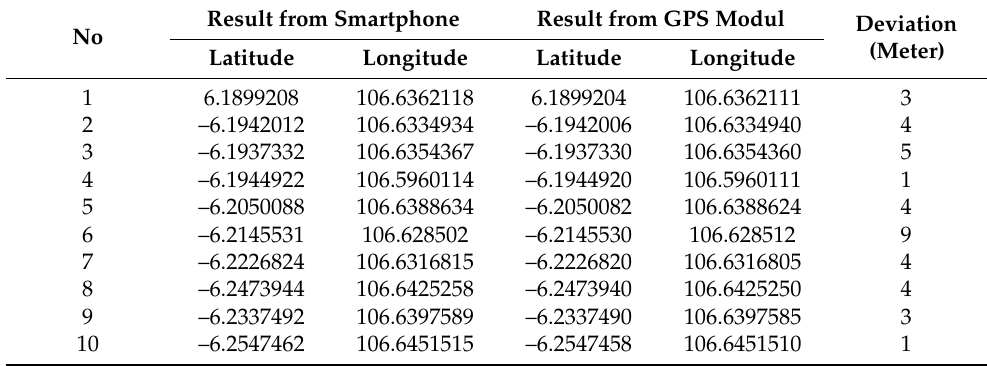
Table 6. Global Positioning System (GPS) test data results.